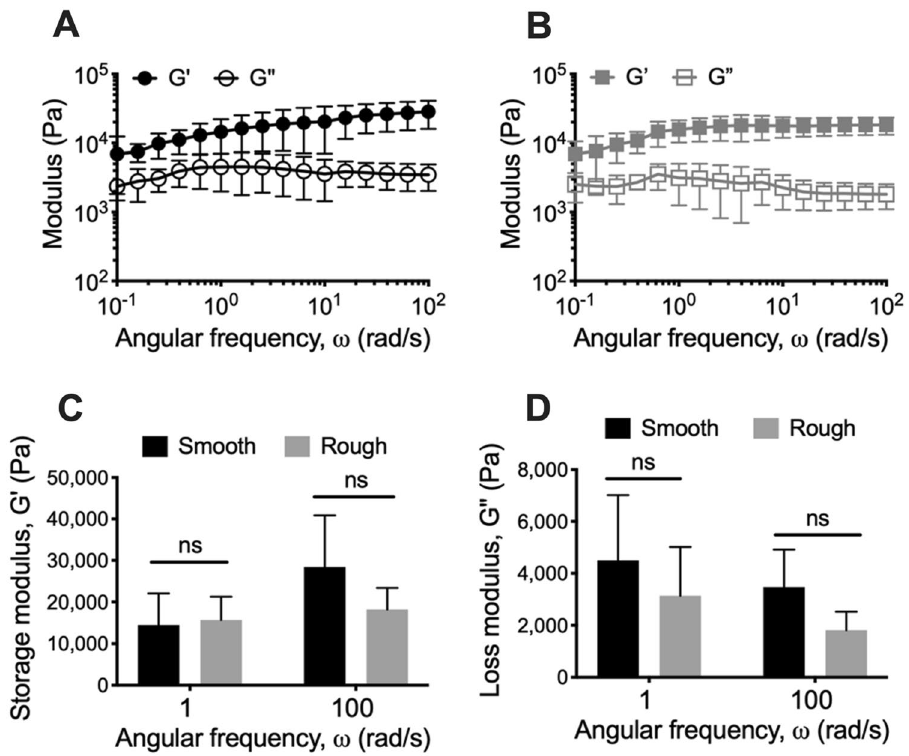
Figure 4. M. abscessus colony-biofilms are highly viscoelastic. Frequency sweep profiles of 4 day (A) Ma Sm and (B) Ma Rg colony-biofilms. G‘ = storage modulus and G” = loss modulus (C) Storage and (D) and loss moduli values at 1 and 100 rad/s. N = 4; data presented as mean ± SD. Statistical analysis was performed using a Student’s t-test; ns indicates not signficant.